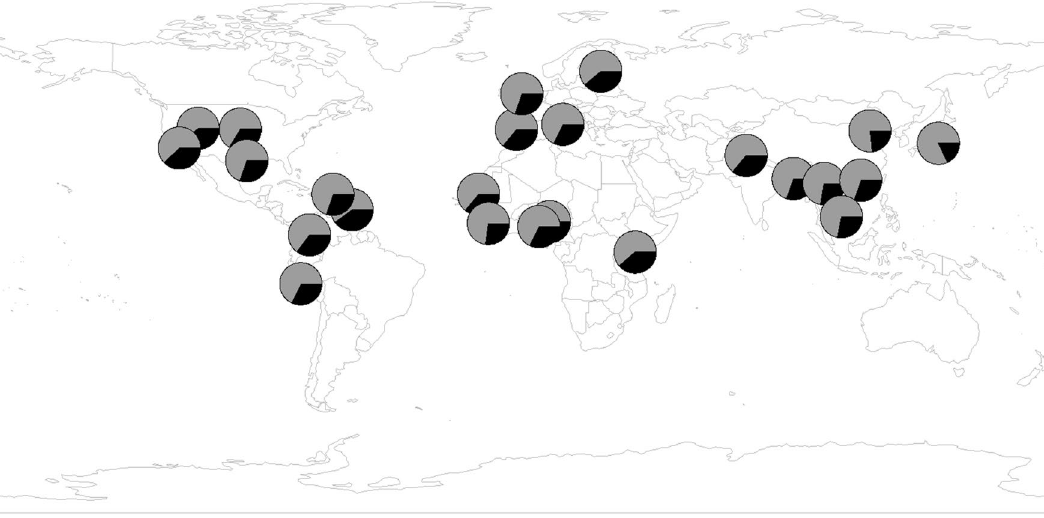
Figure 3. Frequency of the core haplotypes in global populations from 1000G. Each circle represents one population and pie chart displays the haplotype frequency. The gray and black color indicates haplotype 1 and 2,